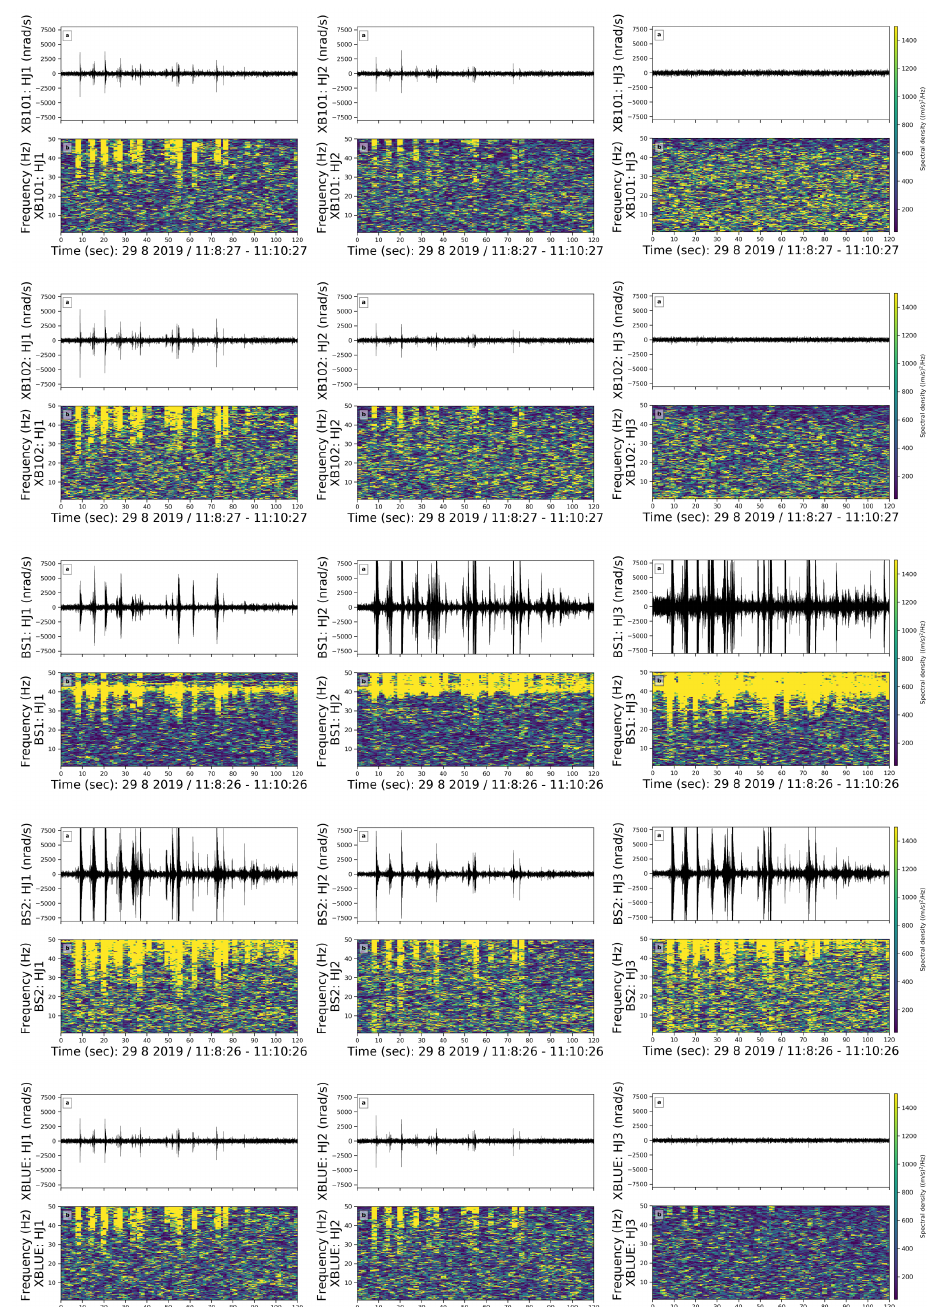
Figure 8. High-frequency spike-shaped noise in a 2 min long time window on doy 241, i.e., 29 August, Thursday. The subfigures and colors are the same as in Figure